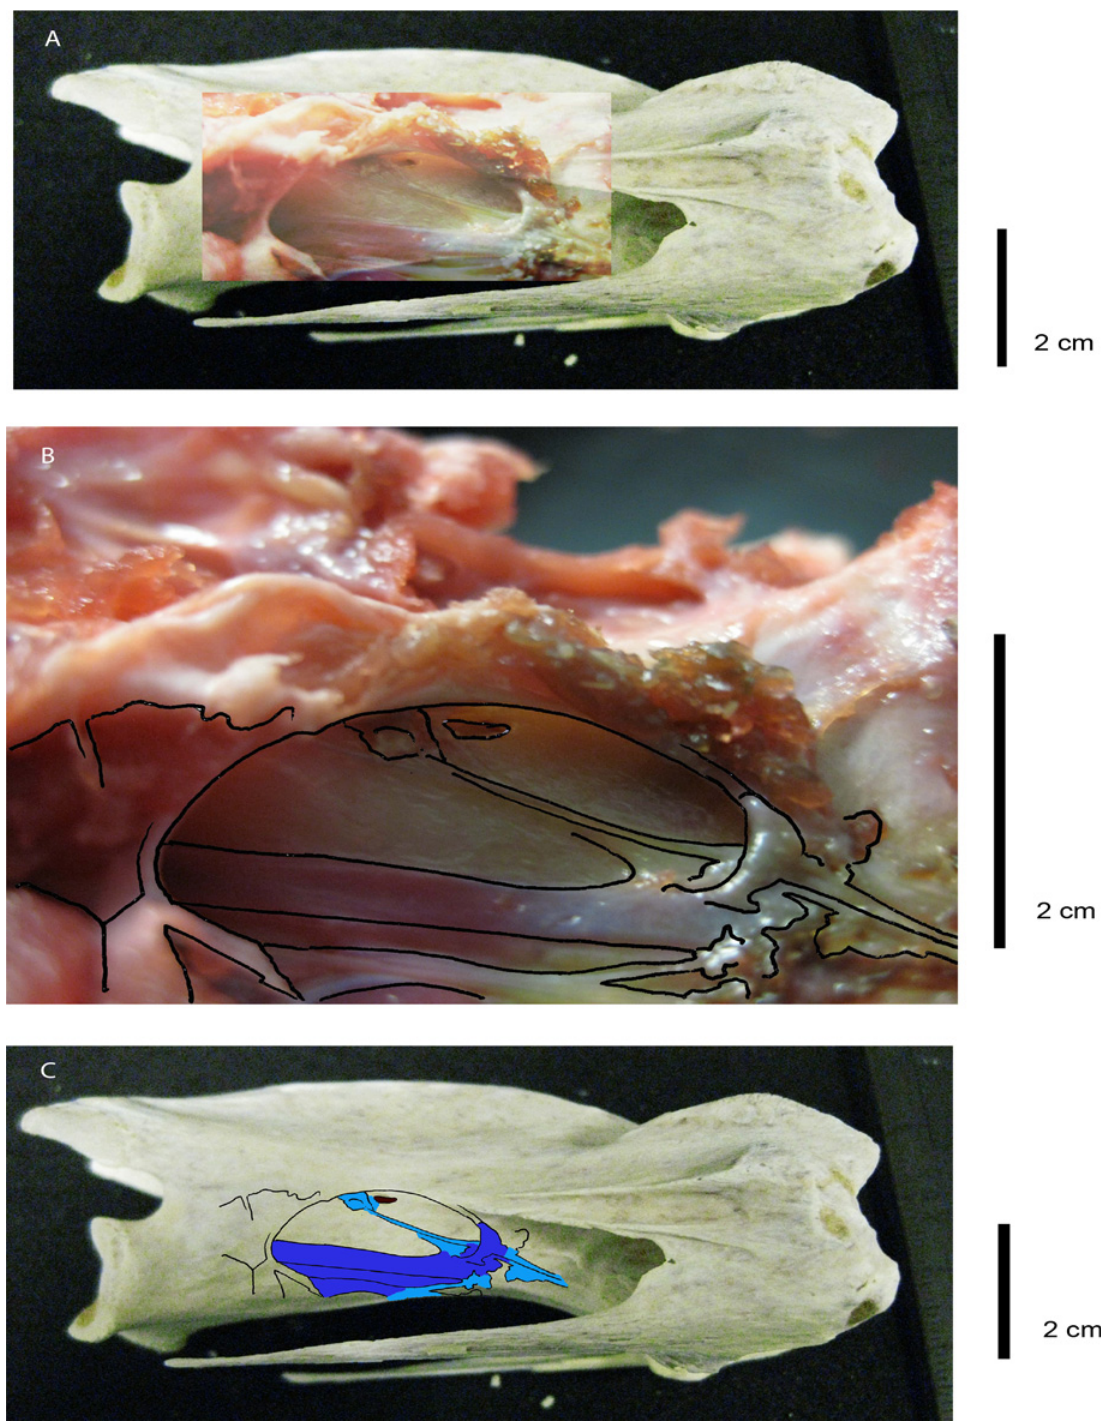
Fig 5. Triple schematic of ostrich vertebra-air sac-flesh tissue system. (A) Depiction of a semi-transparent layer of the actual close-up of the air sac diverticulum system with its surrounding tissue placed on top of the cervical vertebra; (B) Magnified air sac diverticulum and its membranous extensions. The black lines indicate the various folds and borders of the air sac diverticulum and its membranes as they expand on the bone; (C) Only the bony tissue with the schematic representation of the air sac diverticulum/membrane system without the surrounding flesh tissue. Same colour codes apply as described in Fig 2. Please note that the air sac is not inflated and thus intraspecific variation is highly